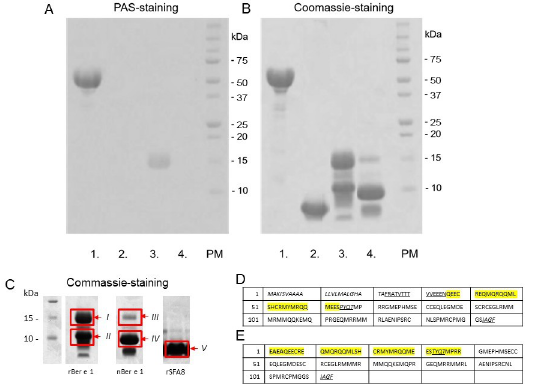
Fig 1. Detection of glycosylation on 2S albumin proteins by periodic acid Schiff’s (PAS) staining. (A.) A positive glycoprotein control, CPDY (1.), rSFA8 (2.), rBer e 1 (3.), and nBer e 1 (4.) were separated on a 12% BisTris NuPAGE gel under denaturing conditions (300 mM DTT) and PAS stained to detect glycoproteins. Only the ~15 kDa band of rBer e 1 and the positive control, CPDY, reacted with the PAS stain, indicating the presence of glycan residues. nBer e 1 and rSFA8 did not react with PAS stain, thus indicate the absence of glycosylation according to this assay. (B.) An identical NuPAGE gel stained with Coomassie brilliant blue shows all of the proteins present. Raw images of Commassie- and PAS-stained gels are presented in (S3 Fig). (C.) rBer 1, nBer e 1 and rSFA8 protein bands were excised for peptide identification. Samples of rBer e 1( I and II ), and nBer e 1 ( III and IV ) and rSFA8 ( V ) were trypsinised and analysed by LC-MSMS analysis. (D.) Amino acid sequence of precursor native Ber e 1 in planta . Italic fonts represent the N-terminal signal sequence, the underlined fonts represent the pre-prosignal sequences, and the italic and underlined fonts represent the short linker and C-terminal linker. These sequences were cleaved and removed to produce mature Ber e 1 in planta that consists of small subunit (yellow highlight) and large subunit. (E.) Amino acid sequence of mature recombinant Ber e 1 retained the spacer sequence (bold fonts) downstream of the Kex2 cleavage site, spacer, and C-terminal vacuolar targeting signal sequence (italic and underlined fonts) and it is made up of small subunit (yellow highlight) and large subunit [16,